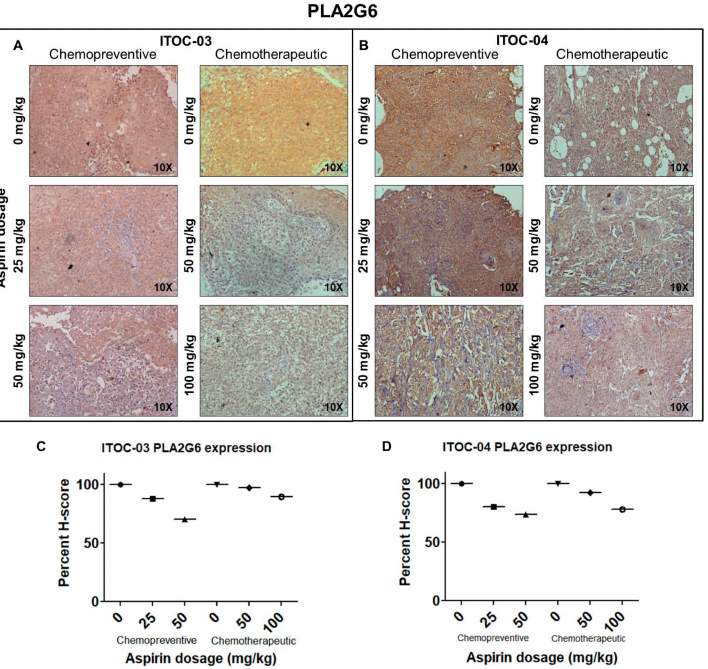
Figure 6. Immunohistochemical detection of PLA2G6 in xenografts generated from